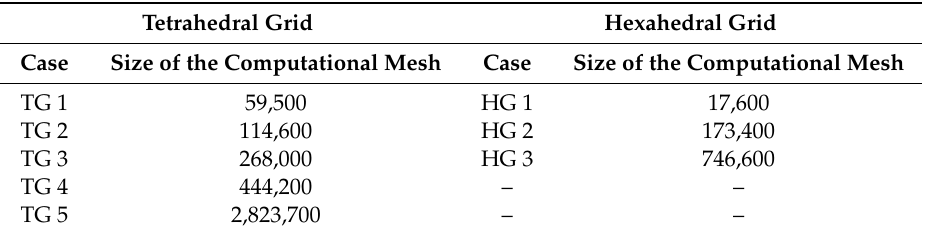
Figure 3. Structure of two different grid types: ( a ) tetrahedral grid (TG); ( b ) hexahedral grid (HG) employed in the grid sensitive study. Table 1. Total number of cells for consecutive grid refinement.